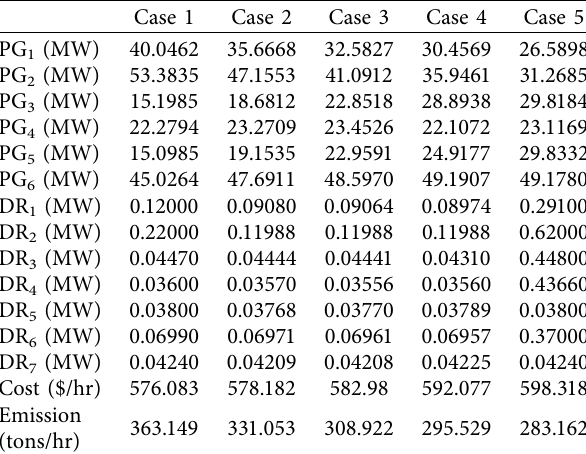
Table 11: Optimized variables for strategy B